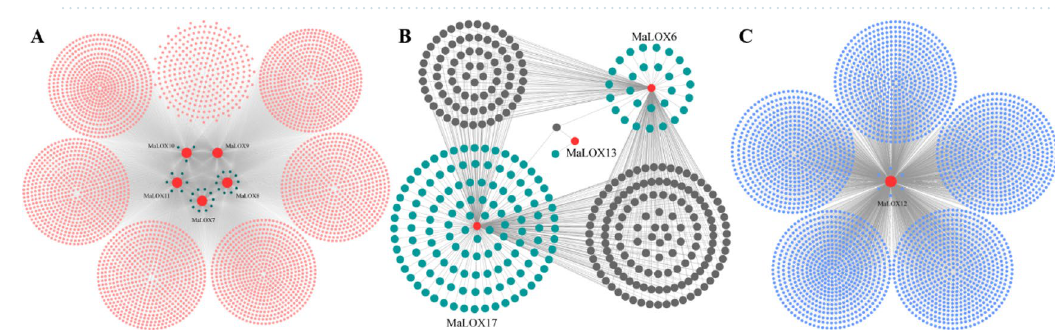
Figure 12. Co-expression network for MaLOX genes. The red nodes indicate MaLOX genes and all other color nodes indicate co-expressed genes with MaLOXs . ( A ) Model 1, ( B ) Model 2, and ( C ) Model